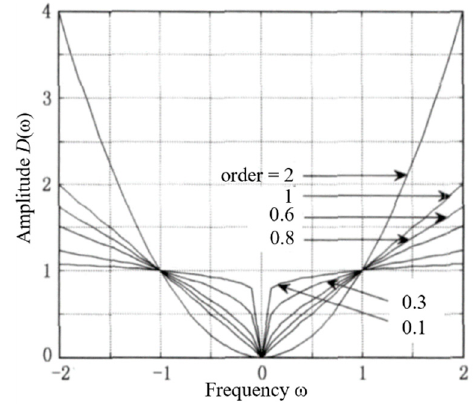
Figure 5. A-F character of fractional order.